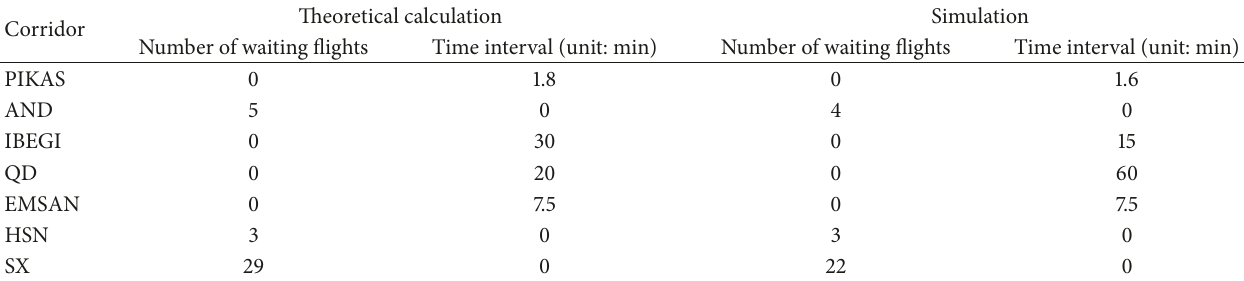
Table 13: Time interval of ATC clearance and number of waiting flights comparison between simulation data analysis and theoretical calculation at corridor.